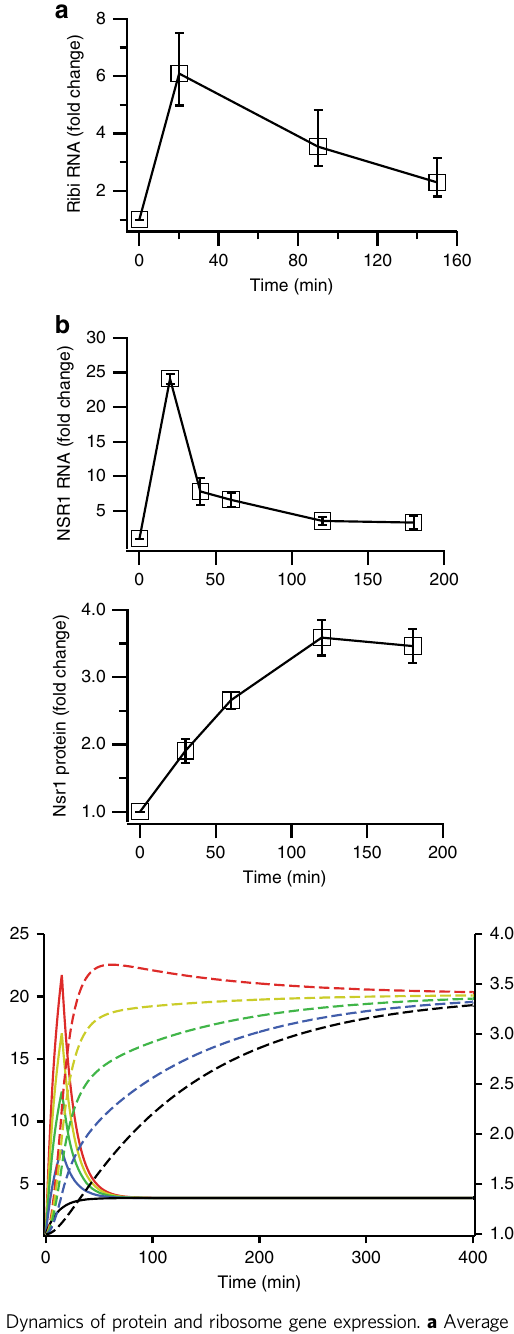
steady-state level of the NSR1 mRNA.